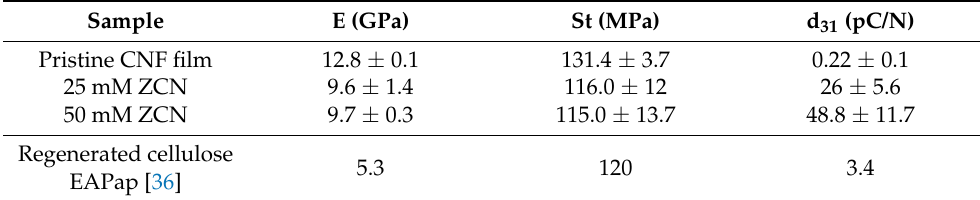
Figure 6. ( a ) Stress-strain curves and ( b ) induced charge curves of the pristine CNF film and ZCNs. Table 1. Mechanical and electromechanical properties of the pristine CNF and